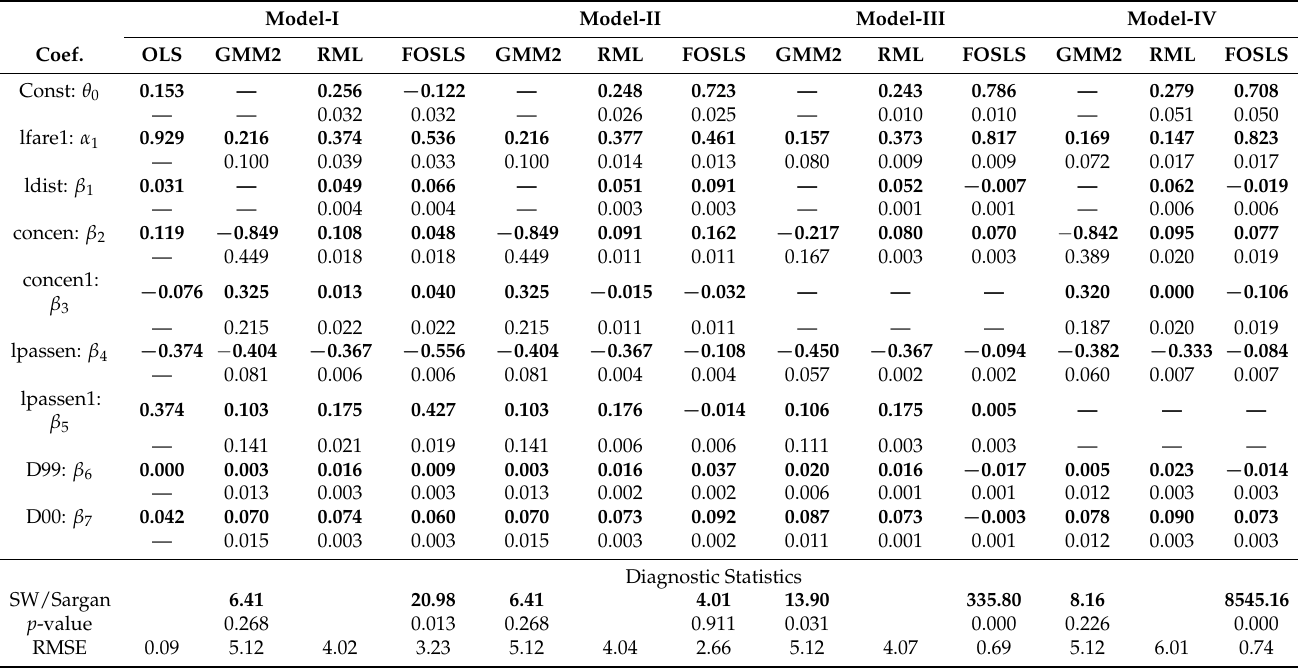
Table 5. The models fitted to airfare data with coefficient estimates in bold and standard errors in regular font. The standard errors of FOSLS and RML are computed using (9) and (A14), respectively. Model-I Model-II Model-III Model-IV Coef. OLS